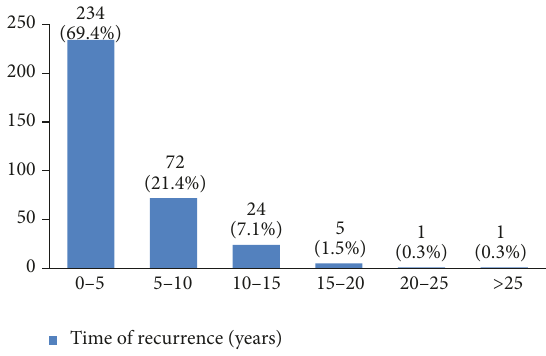
Figure 34: The time of recurrence in the studied cases.